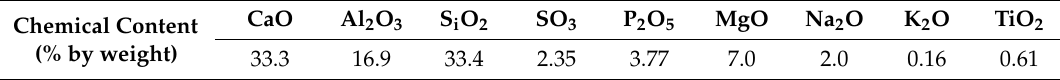
Table 1. Chemical composition of